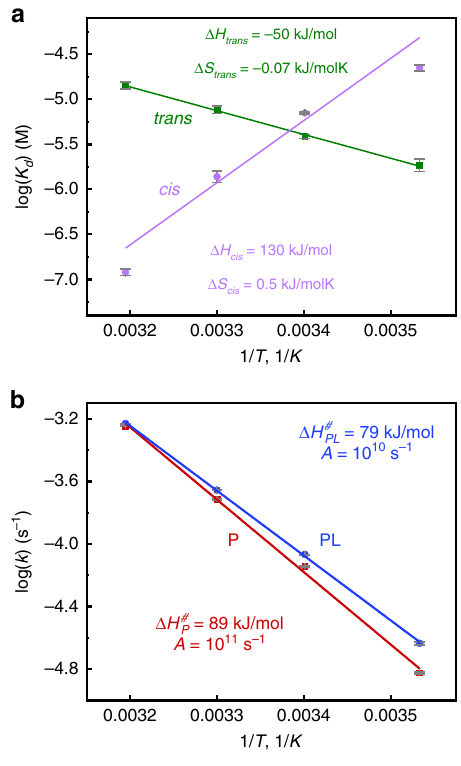
Fig. 3 Energetics. a Van-t ’ Hoff plots of the binding af fi nity of the peptide ligand to the photoswitchable PDZ3 domain in its cis (magenta) and trans -state (green). The binding enthalpies Δ H and entropies Δ S extracted from the linear fi ts are indicated. b Arrhenius plots of the thermal cis -to- trans isomerisation rate for the free protein ( P , in red) or with the ligand bound (PL, in blue). The activation enthalpies Δ H # and the pre-exponential factors A are indicated. All data are also listed in Table 1, and the corresponding titration and relaxation measurements are shown in SI as Figs. S6 and S7. Error bars, which have been estimated from the fi ts of the data shown in Figs. S6 and S7, indicate single standard deviation around the mean. Source data are provided as a Source Data fi